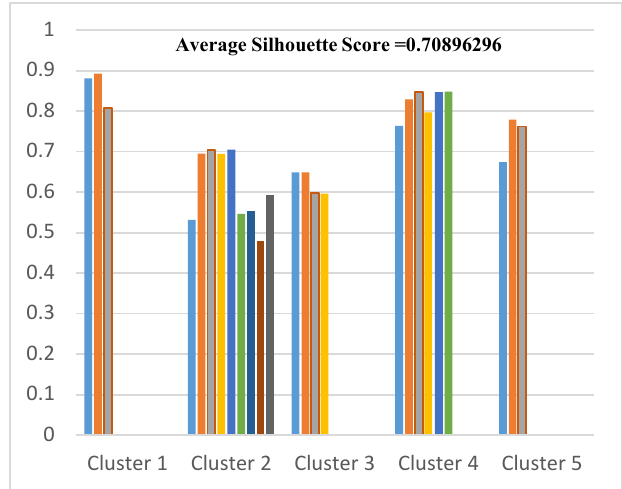
Fig. 6. Average Silhouette score for clustering 25 trajectories with k=6.